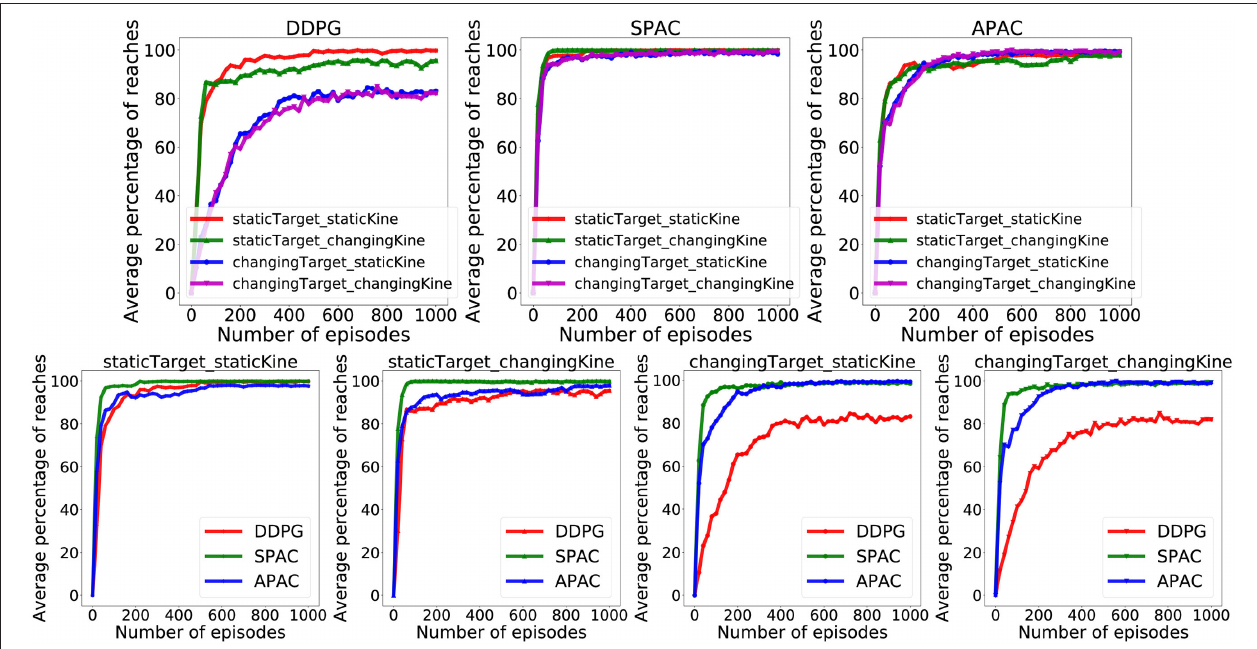
FIGURE 4 | Comparison of the proportion of trials in which the target was successfully reached during training between DDPG, SPAC, and APAC. (Top) highlights differences in each respective model’s performance across the Target/Kinematic experimental combinations. APAC that arbitrates between planning and habits can resist to changes in the target position and kinematic changes, while DDPG is not flexible under either changing condition. (Bottom) plots highlight differences between models within each experimental combination of target position and kinematics. Performance of DDPG (pure habits) drops when target location is changing, while this has no effect on SPAC (exclusive planning) and APAC (arbitrated).